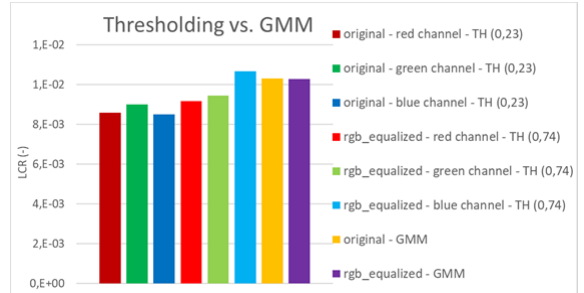
Fig. 12. Liquid content ratio of the